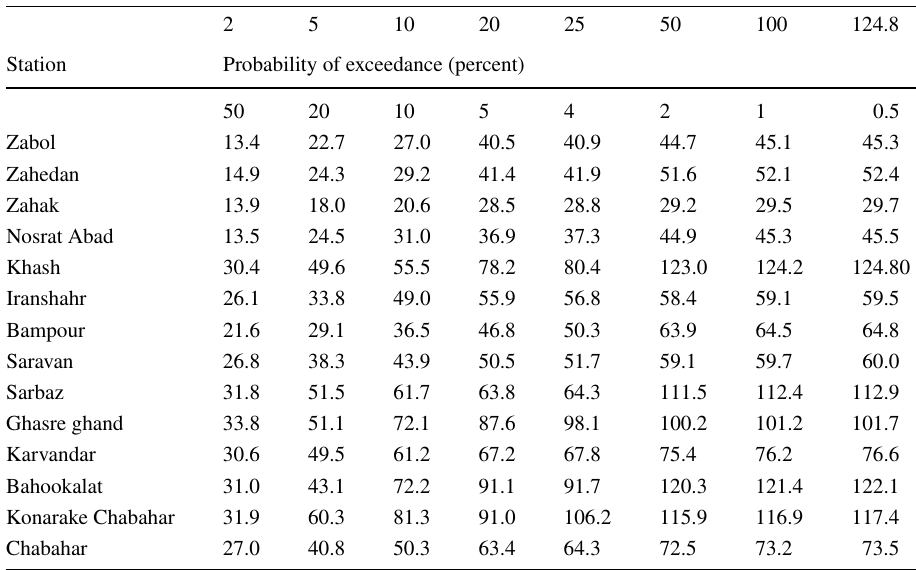
Table 5 Quantiles calculated by Fourier series